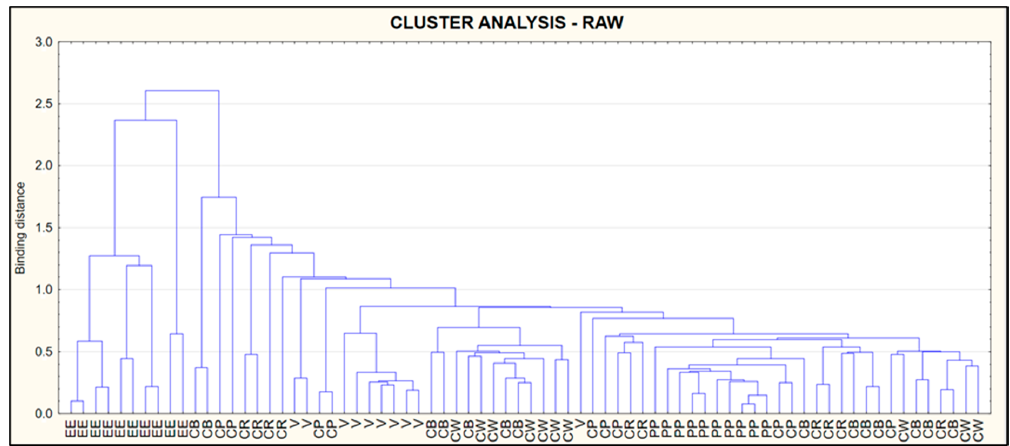
Figure 6. Dendrogram of similarity in protein, fat, salt, collagen and water in raw fish.